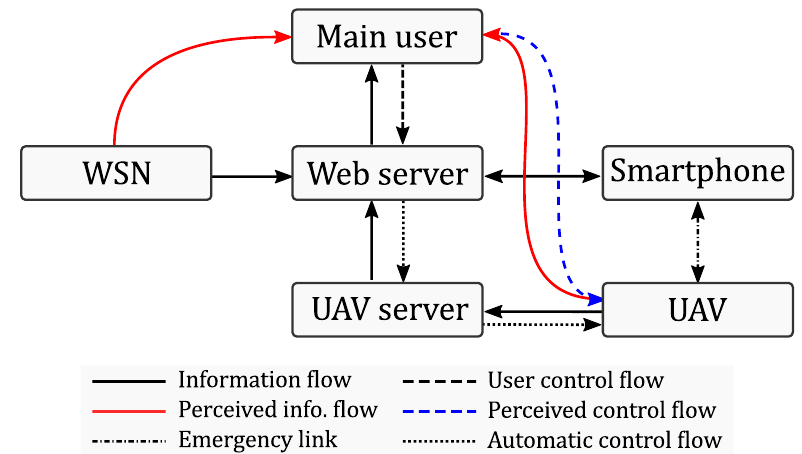
Figure 4. Interconnection among the system